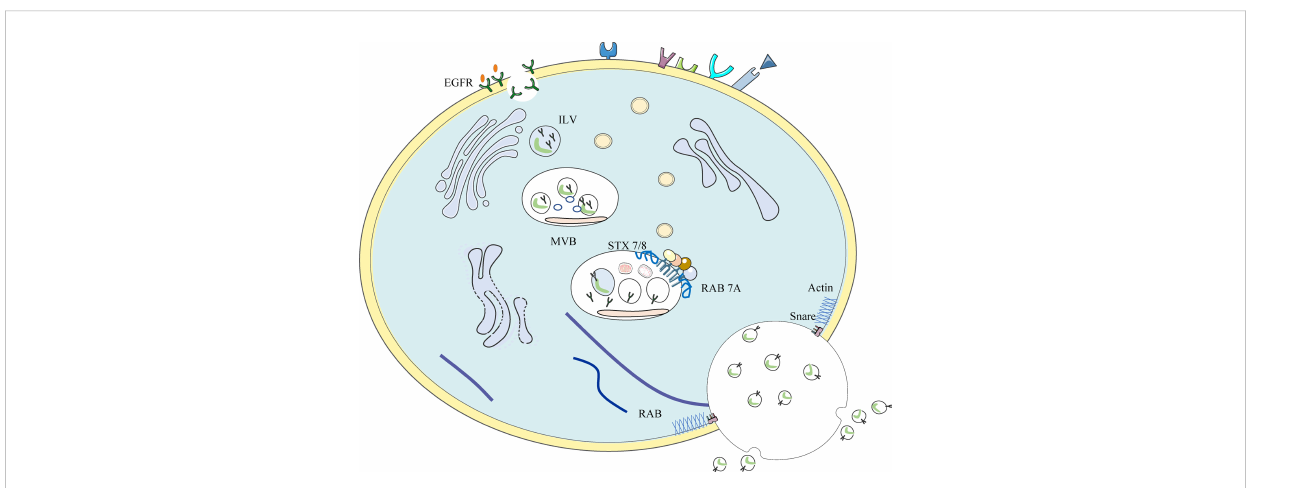
FIGURE 3 Occurrence of EGFR + exosome: Invaginations of the cell membrane containing activated EGFR form membrane bound vacuoles known as early endosomes. Following a series of changes, endosomes mature into late endosomes and subsequently, via the inward budding of the endosomal membrane, membrane-enclosed vesicles called intra-luminal vesicles (ILVs) are formed within the endosome. Multiple inward budding events fi ll endosomes with ILVs; at this stage endosomes become referred to as multivesicular bodies